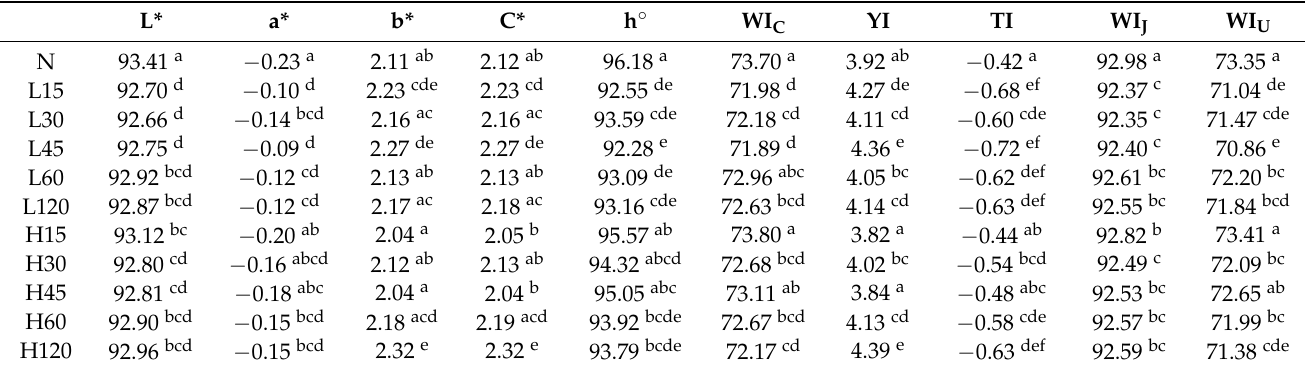
Table 2. Color analysis of native starch and distarch phosphates (SPEX, D65, CIE